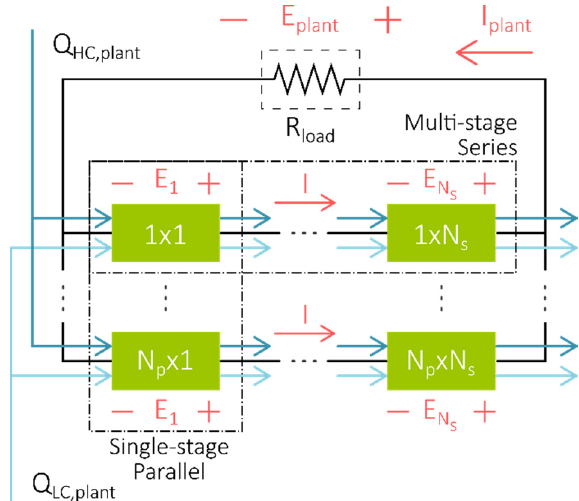
Figure 2. RED plant’s layout: N p parallel branches each with N s stacks arranged in series.